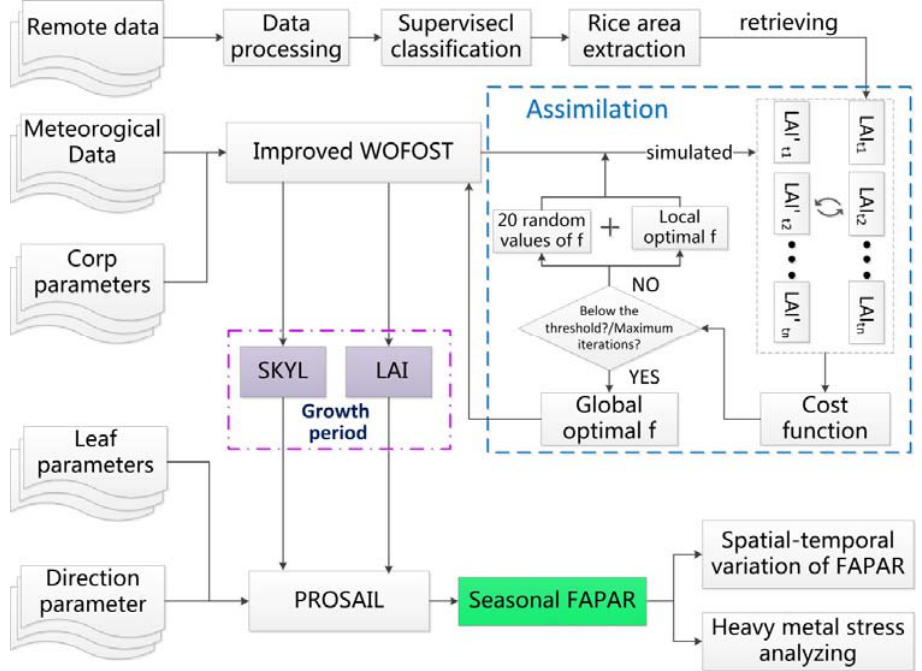
Figure 2. Flowchart for estimating daily fraction of absorbed photosynthetically active radiation (FAPAR) of rice growth season for analyzing heavy metal stress.